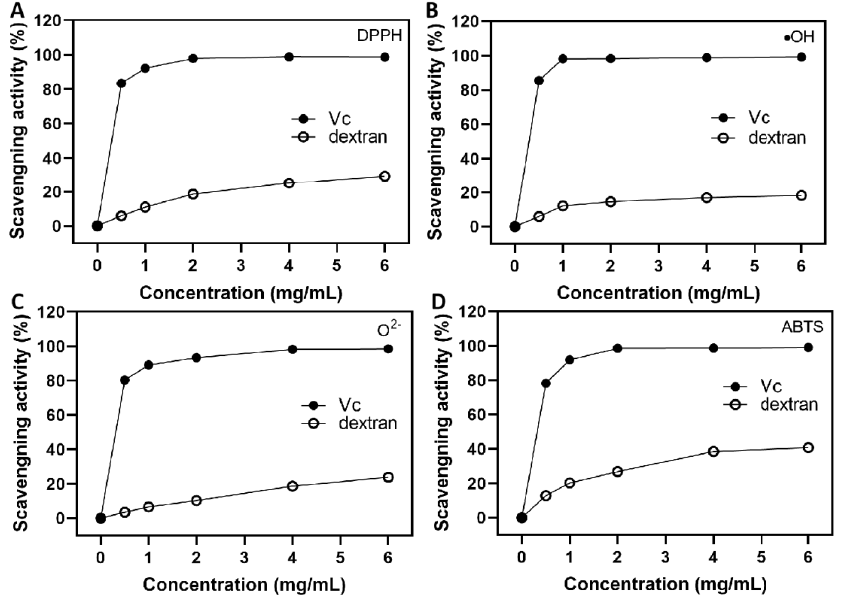
Figure 6. The antioxidant activity of dextran. ( A ) Scavenging ability of DPPH; ( B ) scavenging ability of •OH; ( C ) scavenging ability of O 2- ; ( D ) scavenging ability of